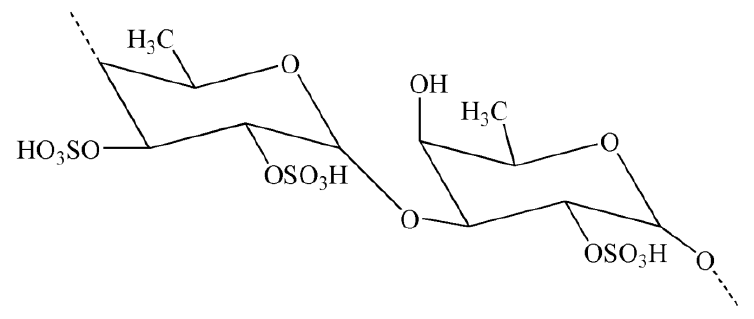
Figure 4. Chemical structure of fucoidan.